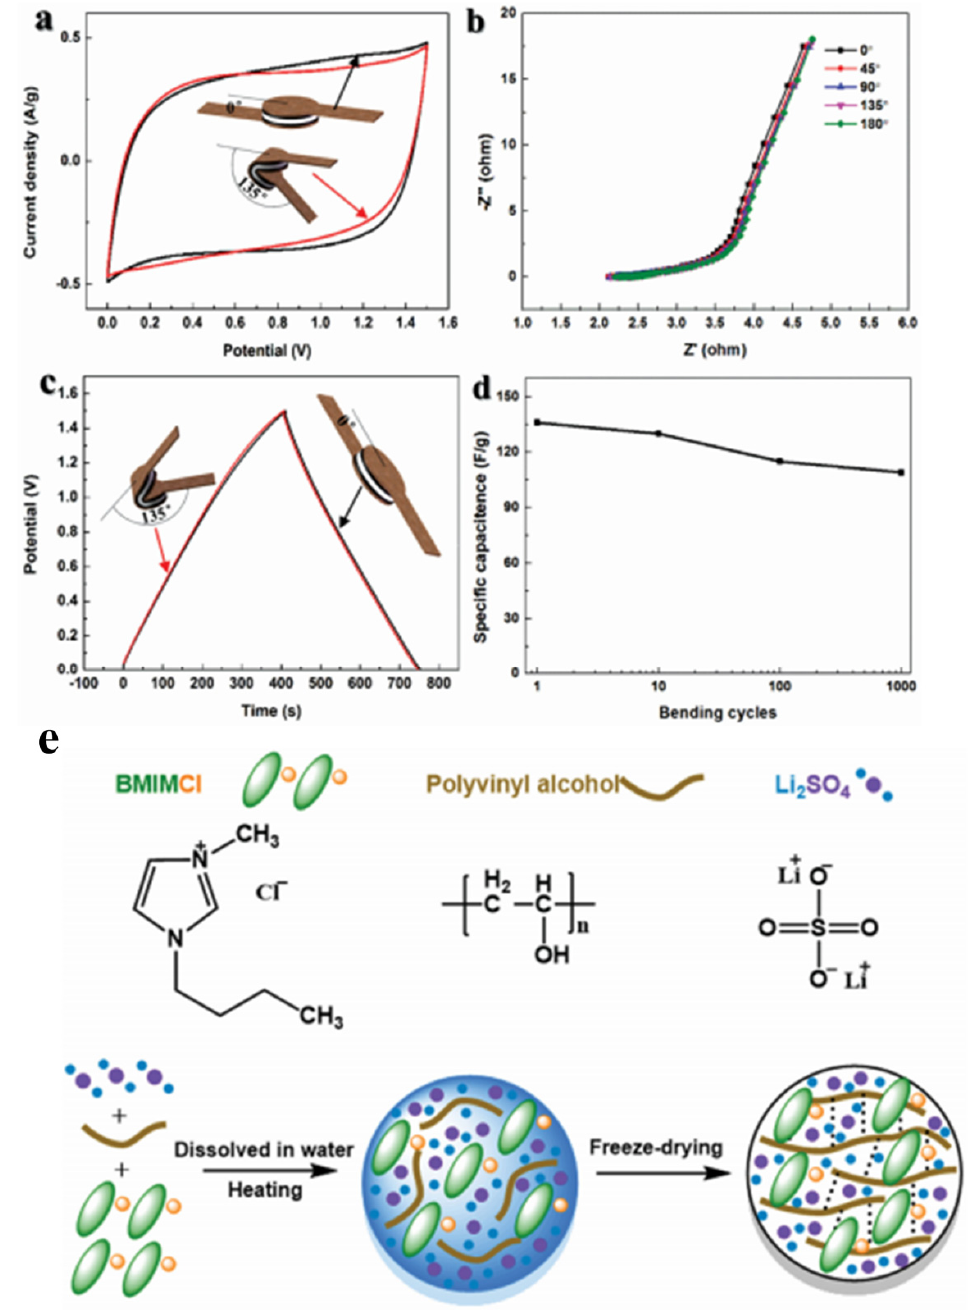
Figure 14. ( a ) Cyclic voltammogram for the SCs of PVA-[BMI][Cl]-Li 2 SO 4 FGPE with bending test at a scan rate of 10 mV s − 1 ; ( b ) Nyquist plot for the SCs of PVA-[BMI][Cl]-Li 2 SO 4 FGPE at different bending angles; ( c ) galvanostatic charge-discharge for the SCs of PVA-[BMI][Cl]- Li 2 SO 4 FGPE with bending test at a current density of 0.15 A g − 1 ; ( d ) variation of specific capacitance after 1000 bending cycles (bending angle = 135 ◦ ); ( e ) synthesis of PVA-[BMI][Cl]- Li 2 SO 4 FGPE. Reprinted from [151] with permission from Advanced Materials Technologies.